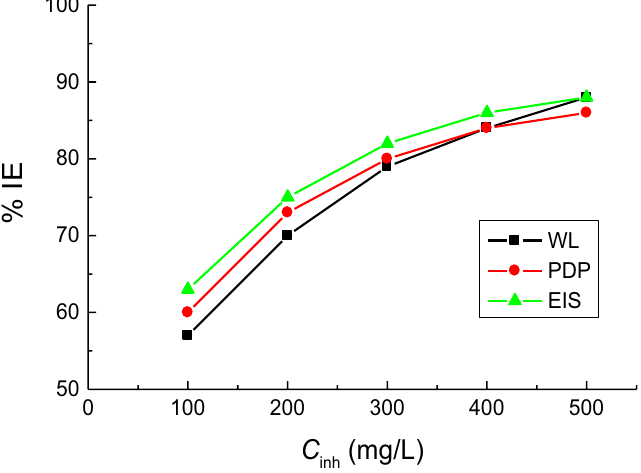
Figure 10. Comparison of different techniques employed for investigation of the copper corrosion inhibition by the surfactant TS in 1.0 M H 2 SO 4 solution at 298